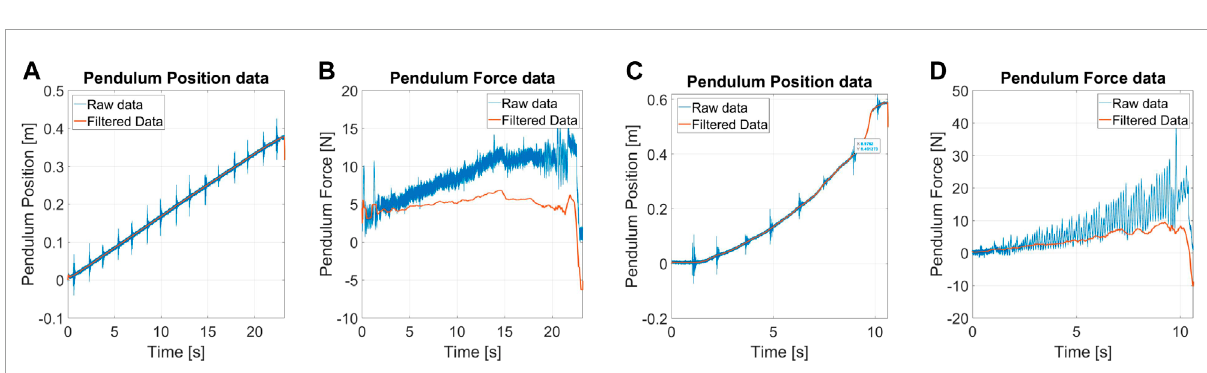
FIGURE 11 (A) angular position and (B) force estimation for the quasi-static displacement disturbance experiments, and (C) angular position and (D) force estimation for the quasi-static force disturbance experiments.